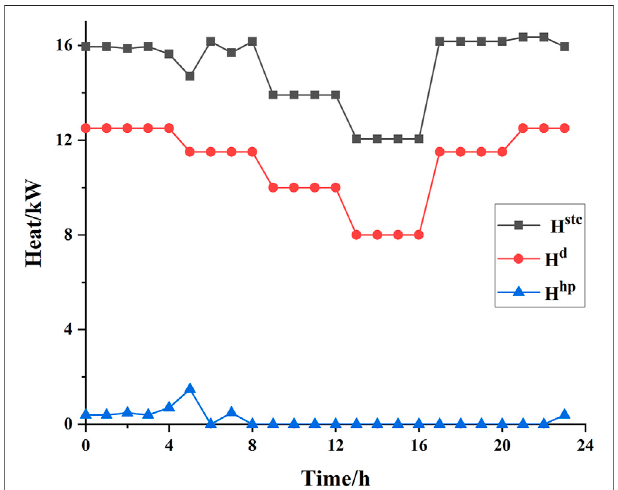
FIGURE 10 | The power balance of ZCE-MEN.